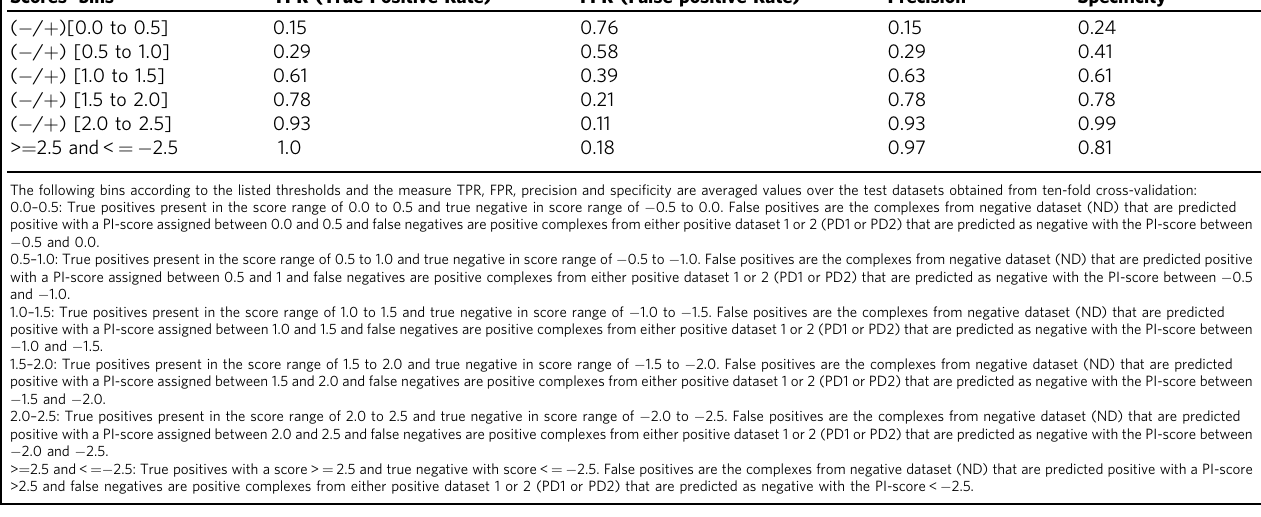
Table 1 Performance in different bins of the scores using the SVM machine learning-based classi fi er. Scores ’ bins TPR (True Positive Rate) FPR (False positive Rate) Precision Speci fi